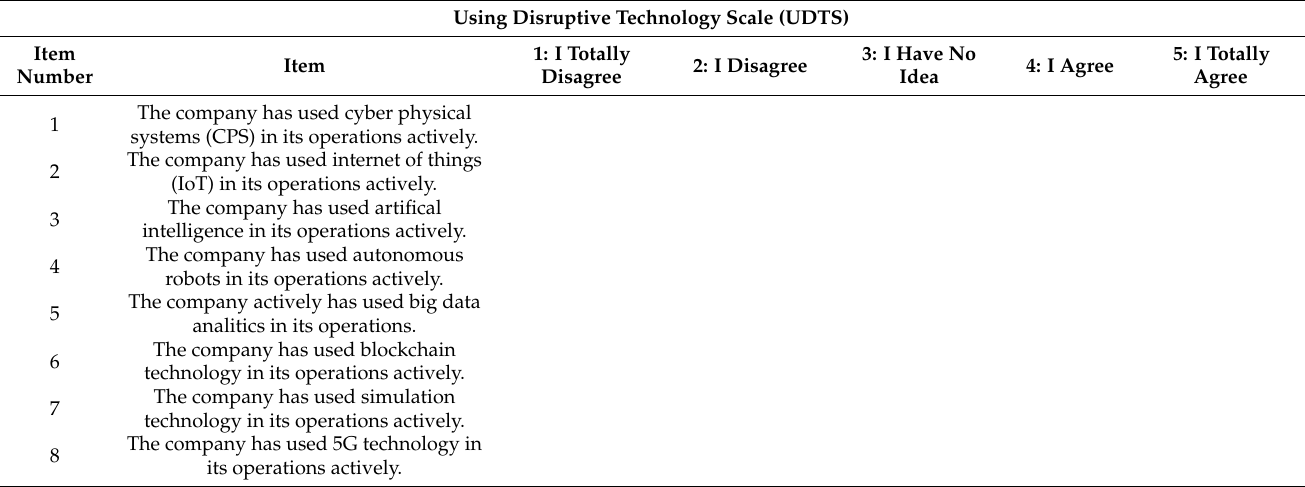
Table A3. The Final Form of the